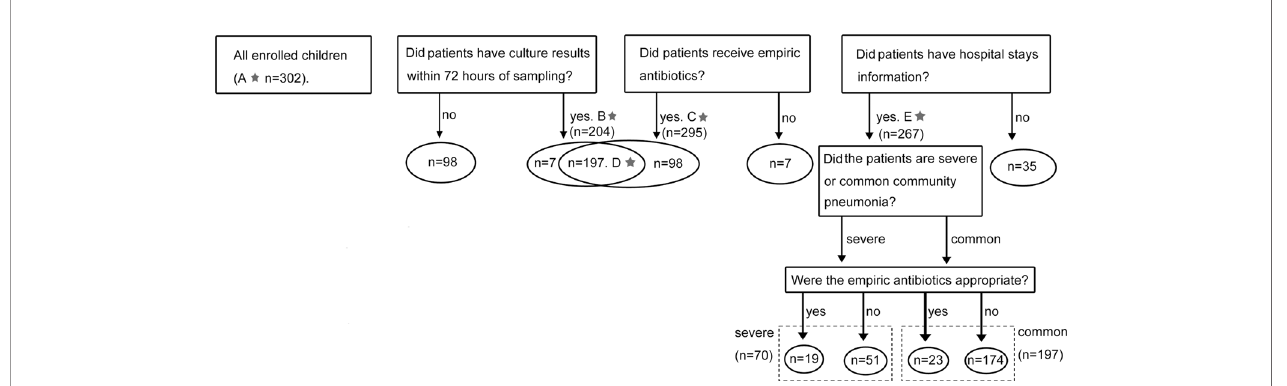
FIGURE 1 | Cases enrolment and study design. The numbers marked with a star referred to the sample size of fi ve groups. (A) Results of combined-MS methods obtained from all 302 patients were used to de fi ne the etiology of CAP. (B) 204 cases with culture results within 72 hours of sampling were used to compare the performance of combined-MS methods and culture. (C) 295 cases with information of empirical antimicrobial therapy were used to study the value of combined-MS methods in guiding antimicrobial prescribing. (D) 197 cases with both information of culture and empirical antimicrobial therapy were used to investigate the impact of antibiotic usage on the performance of combined-MS methods and culture. (E) 267 patients with information of LOS were used to assess how antibiotic therapy affect LOS. LOS, length of